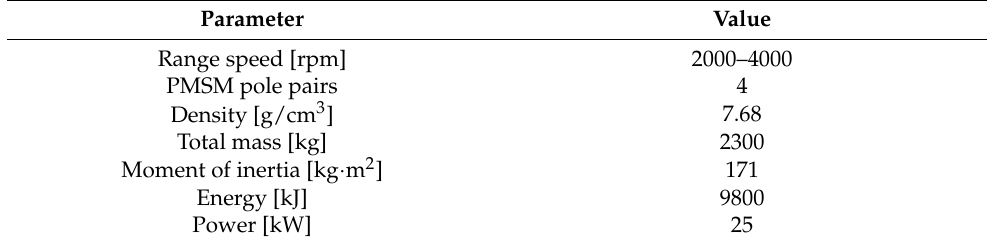
Figure 7. Totally encapsulated Flywheel and its Permanent Magnet -electrical machine. Table 2. Characteristics of the flywheel total